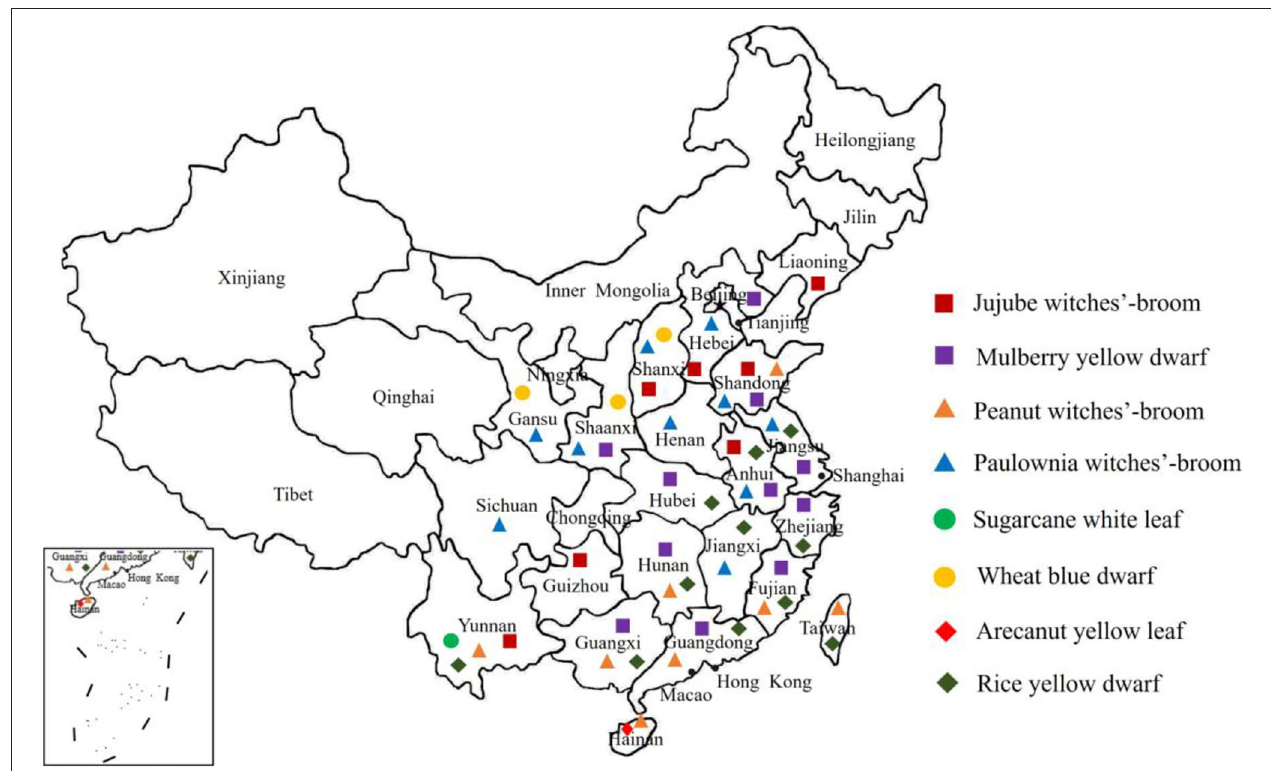
FIGURE 1 | Distribution of main phytoplasma diseases in